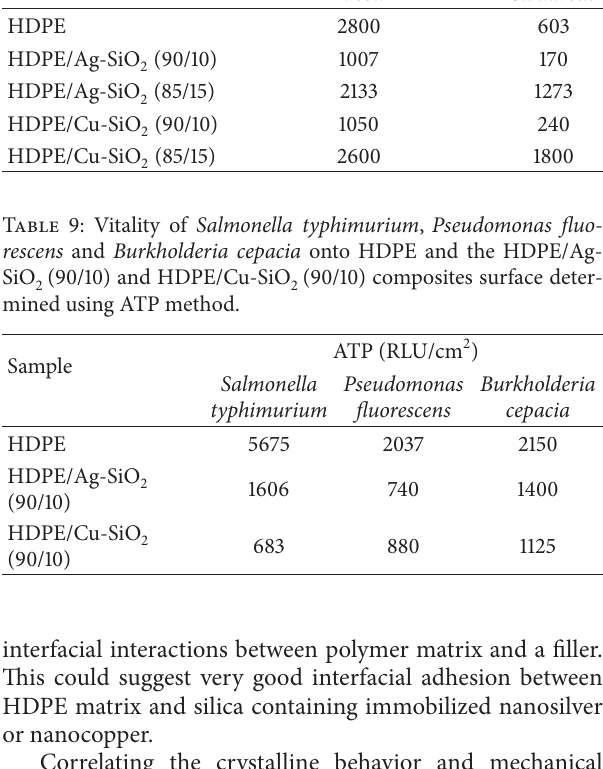
Table 8: Vitality of E . coli and St . aureus onto HDPE and and HDPE/Cu-SiO composites surface deter- the HDPE/Ag-SiO 2 2 mined using ATP method. Sample